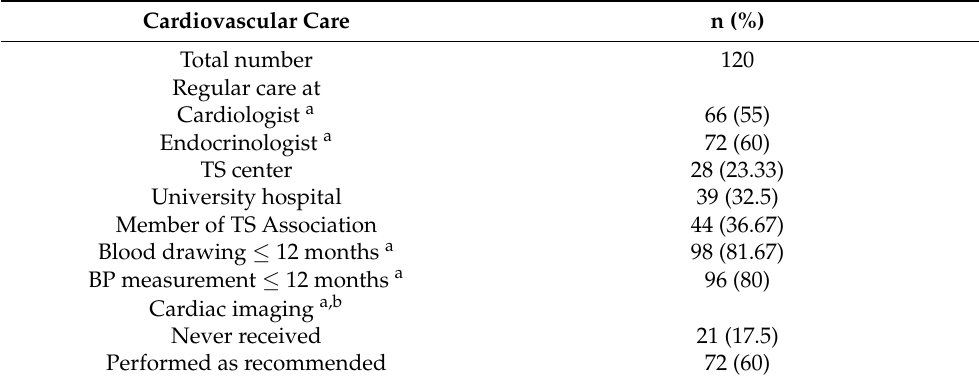
Table 2. General cardiovascular care of TS women in Germany.